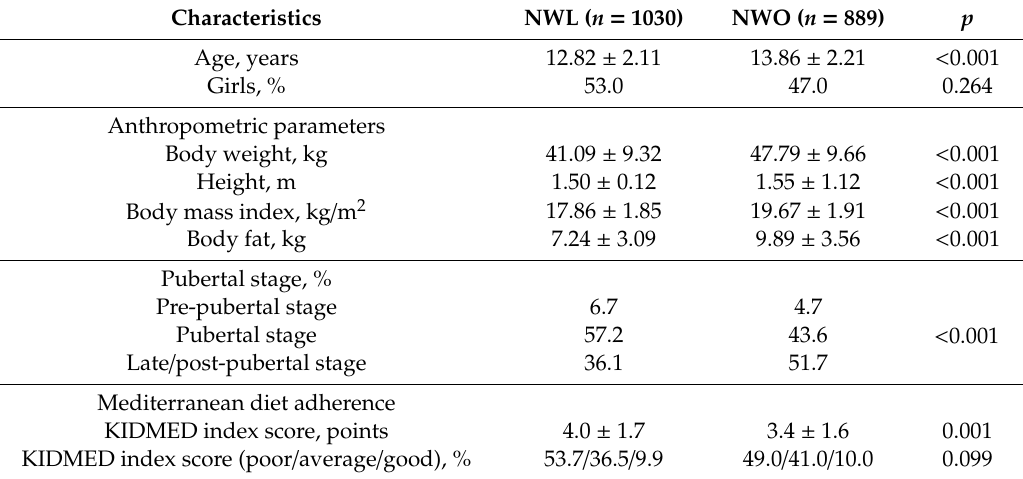
Table 1. Characteristics of the study sample of normal-weight lean (NWL) and normal-weight obesity (NWO)